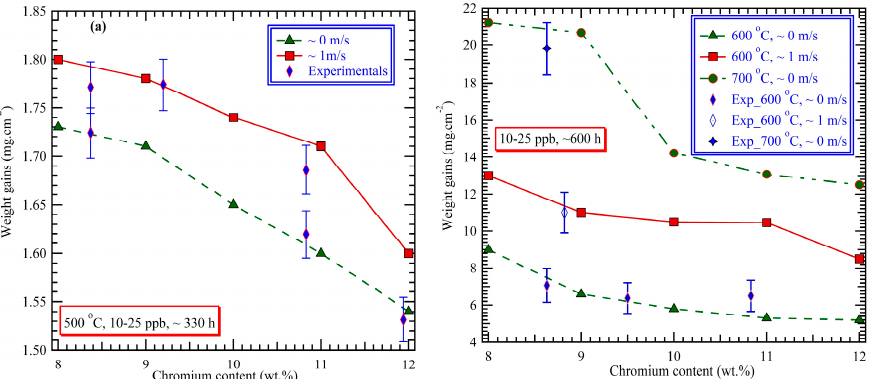
Figure 5. Predicted-weight gains of F-M steels vs. chromium content at ( a ) 500 °C, ( b ) 600 °C and 700 °C, as a function of flow rate.